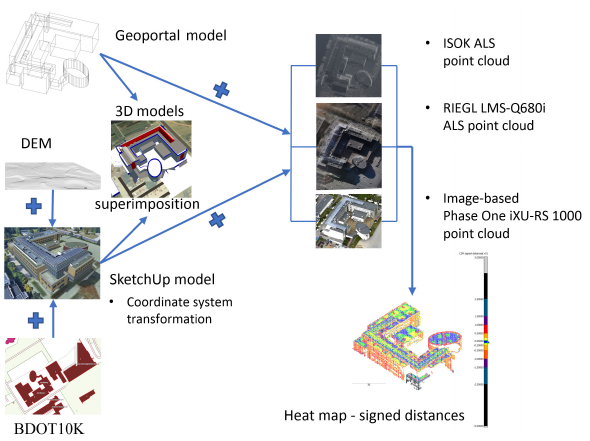
Figure 6. Workflow for 3D models accuracy